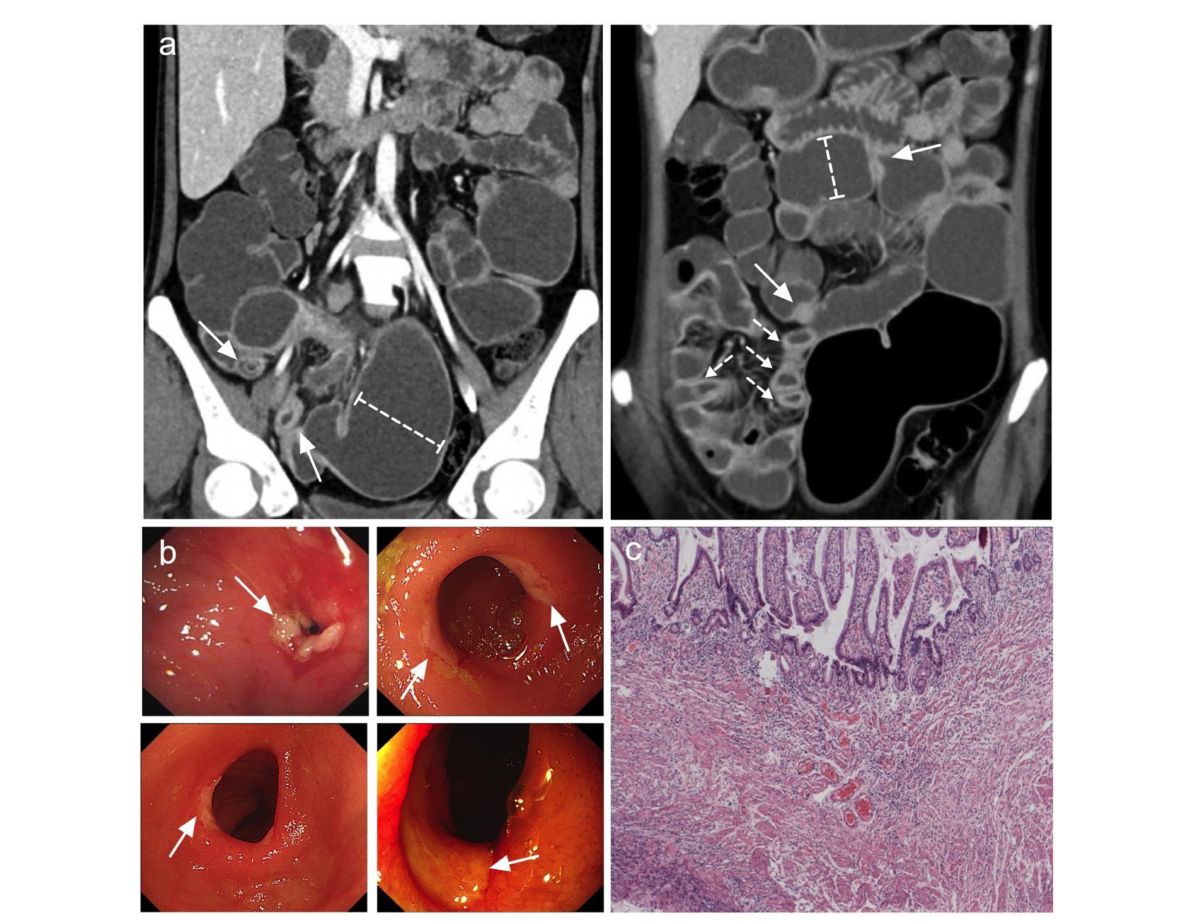
FIGURE1 Most common features observed in CMUSE. (a) Coronal CT enterography images demonstrate multiple short strictures, with mild stratified hyperenhancement (arrows) and proximal lumen dilation (dashed-capped lines). (b) Double balloon enteroscopy demonstrates circumferential shallow ulcers in ileum or jejunum (arrows). (c) HE stain of the ileum demonstrates superficial ulcers involving mucosa and submucosa with angioectasia and congestion.